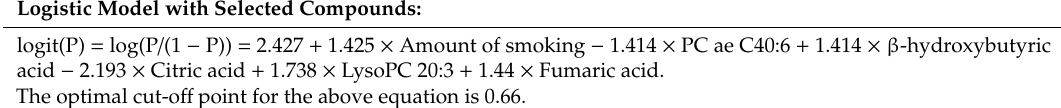
Table 7. Logistic regression based optimal model for stages I + II NSCLC detection: metabolites plus smoking